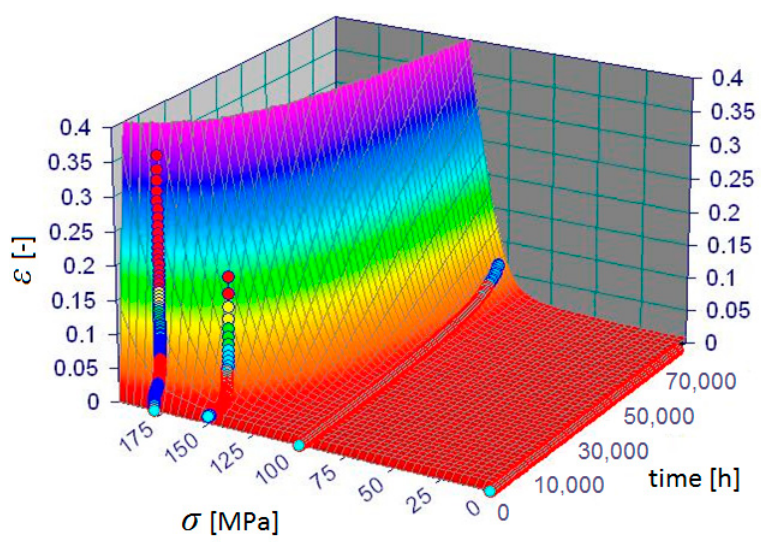
Figure 5. Real measured and modeled creep strains [-] for Super 304H steel in the temperature of 665 ° C.